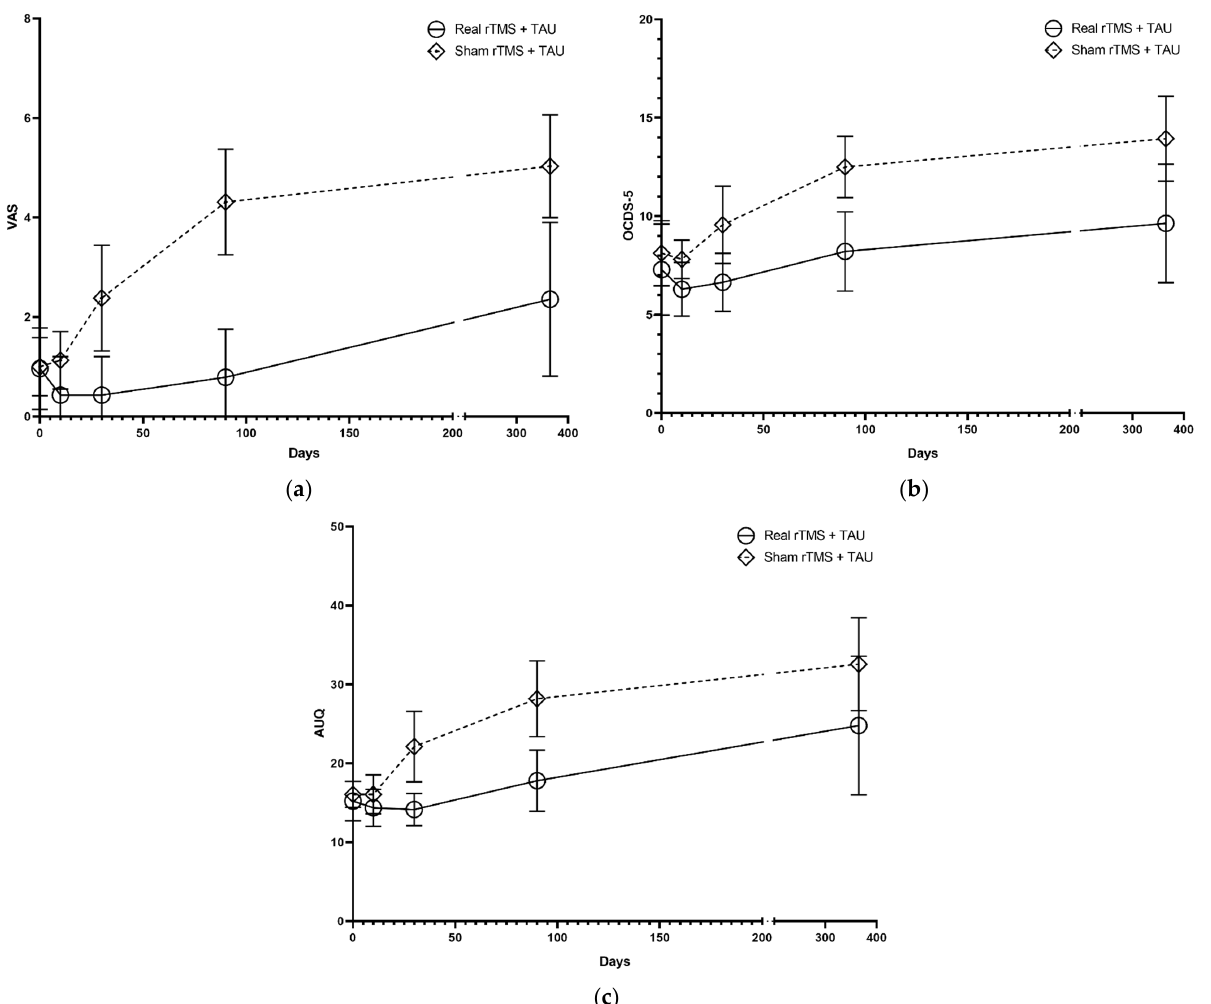
Figure 3. Effect means with 95% CI of rTMS on outcome measurements over time for ( a ) Visual analog scale (VAS), ( b ) Obsessive ‐ compulsive drinking scale (OCDS ‐ 5), and ( c ) Alcohol urge questionnaire (AUQ).